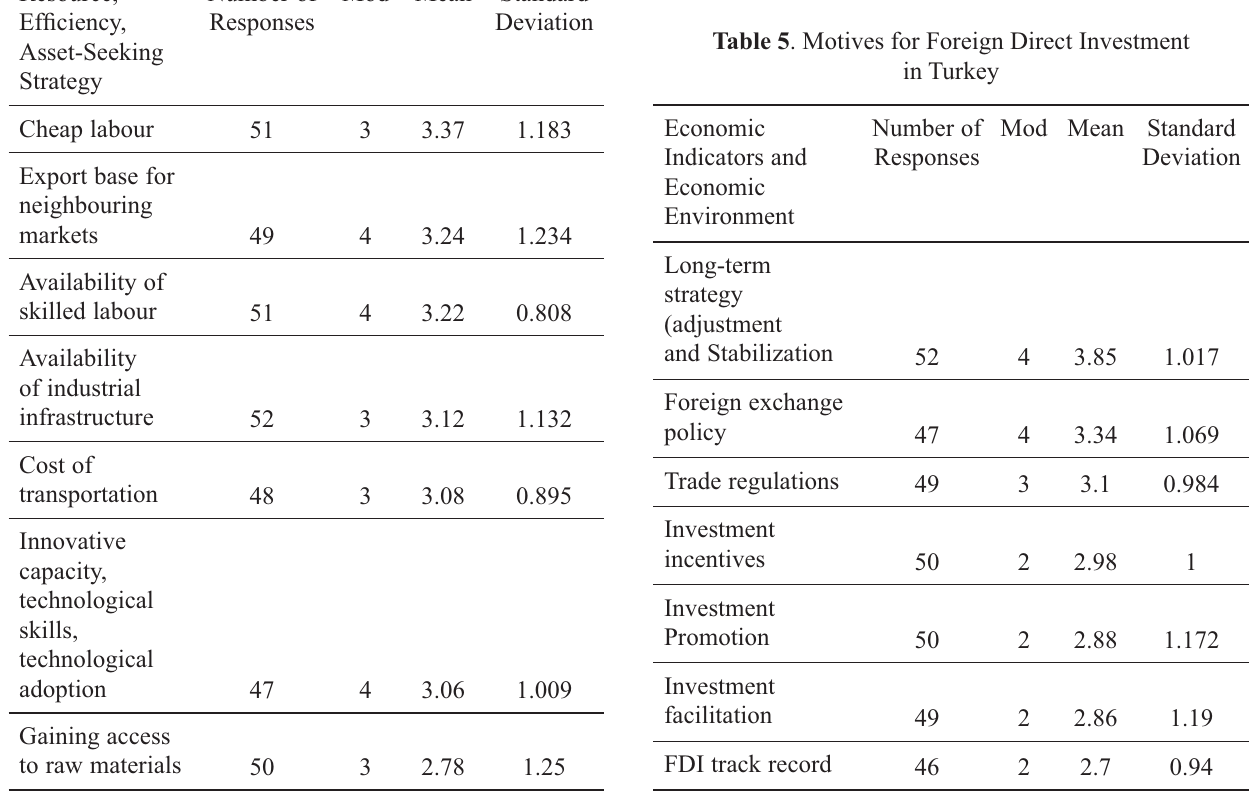
Table 4 . Motives for Foreign Direct Investment in Turkey Resource,